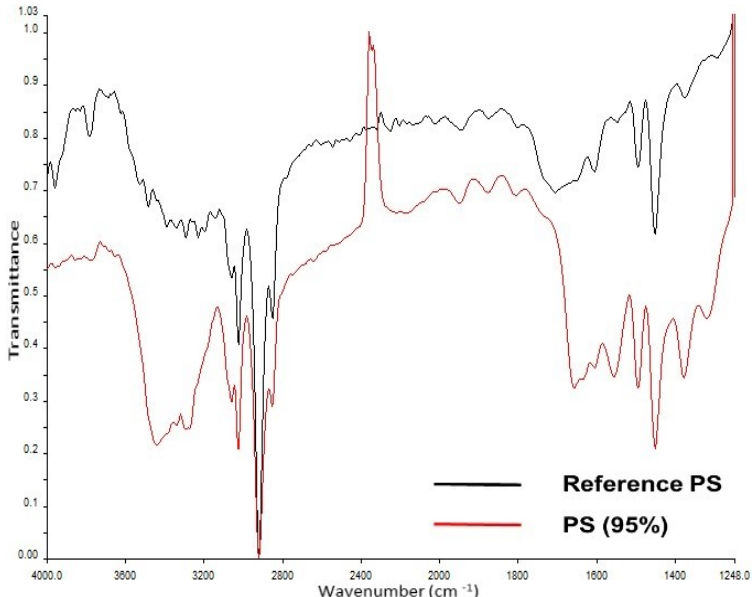
Figure 4. Measured IR spectrum in the sample (in red) and reference spectrum from in-house library (in black) for polystyrene. Table 1. ( A – C ): First phase screening for microplastic particles in ( A ) human placenta, ( A ) meconium, ( B ) maternal stool, and ( C ) contamination controls (0.05–0.5 mm). Negative controls include screening for MPs of sample preparation instruments and storage containers without the actual tissues (placenta, meconium, maternal stool). PE = polyethylene, PP = polypropylene, PVC = polyvinylchloride, PS = polystyrene, PET = polyethylene terephthalate, PA = polyamide, PU =